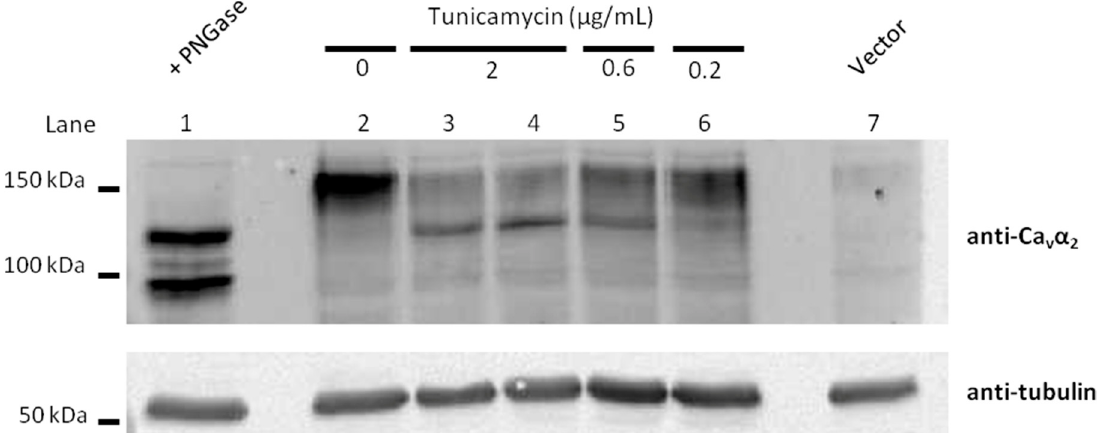
Figure 2. Hypoglycosylation levels of the Ca V regulatory α 2 δ subunits under different concentrations of tumicamycin. Immunoblot analysis of glycosylated fragments of α 2 δ subunits heterologously expressed in HEK293 cells (along with the α 1A Ca V 2.1 pore-forming channel subunit and β 3 regulatory subunit), treated or not with increasing concentrations of tunicamycin (0.2, 0.6 and 2 μ g/mL, as indicated). The extent of α 2 δ glycosylation was identified by using antibody anti- α 2 (1:500 dilution, Sigma D219, St. Louis, MO, USA) (top panels) and is shown as the difference in molecular weight between the glycosylated and unglycosylated forms. Molecular weight markers are indicated on the left. PNGase F was also added to protein extraction from tunicamycin-untreated cells in order to identify unglycosylated forms in vitro. Upper bands potentially corresponding to glycosylated α 2 δ progressively decrease as the concentration of tunicamycin increases, which in turn promotes the appearance of a lower band potentially corresponding to unglycosylated α 2 δ (lanes 2 to 6). In vitro PNGase F treatment (lane 1) shows two main bands potentially corresponding to unglycosylated α 2 δ (upper band) and unglycosylated α 2 (lower band), as previously reported [26].Protein extraction from HEK293 cells transfected only with the vector plasmid was included as negative control (lane 7). For each experimental condition, the protein sample was probed with anti-tubulin (1:2000 dilution, Sigma T6074) (bottom panel) as loading control.